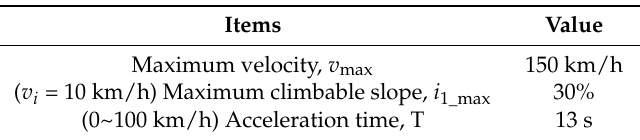
Table 1. Vehicle performance requirements.